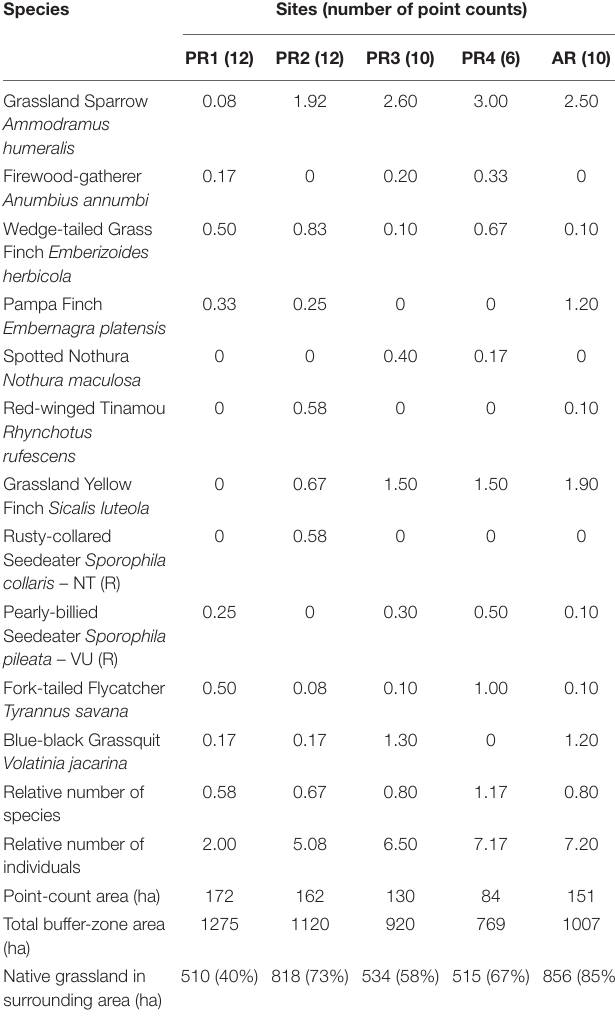
TABLE 1 | Relative number of grassland-bird species and individuals per point count, and area of native grassland in passive (PR) and active (AR) restoration sites in Brazilian Pampa